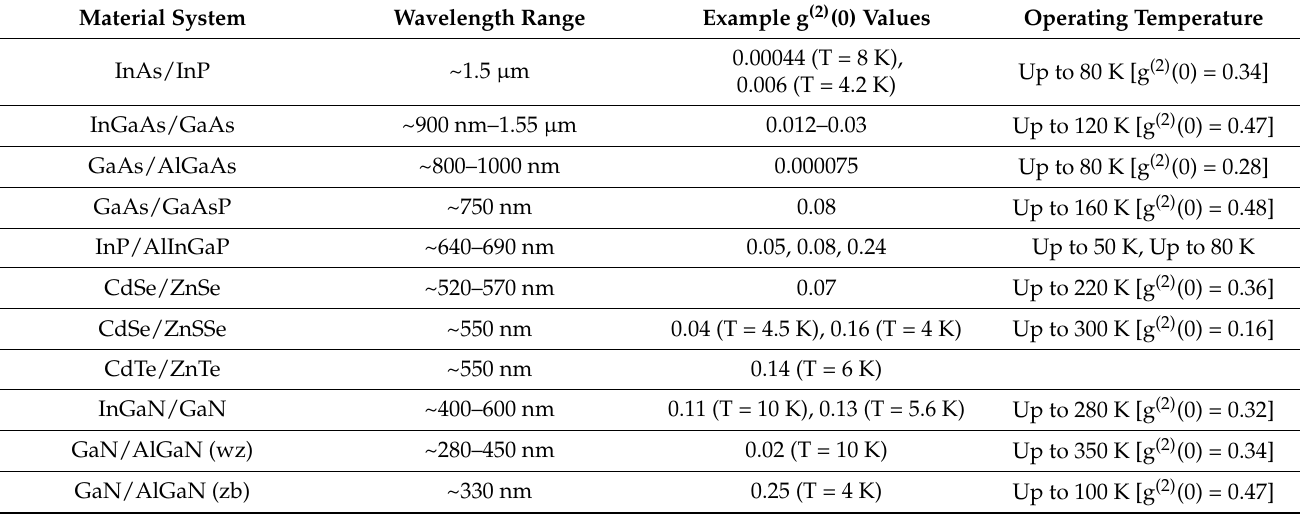
Table 1. Overview of properties of various epitaxially grown QD single-photon emitters